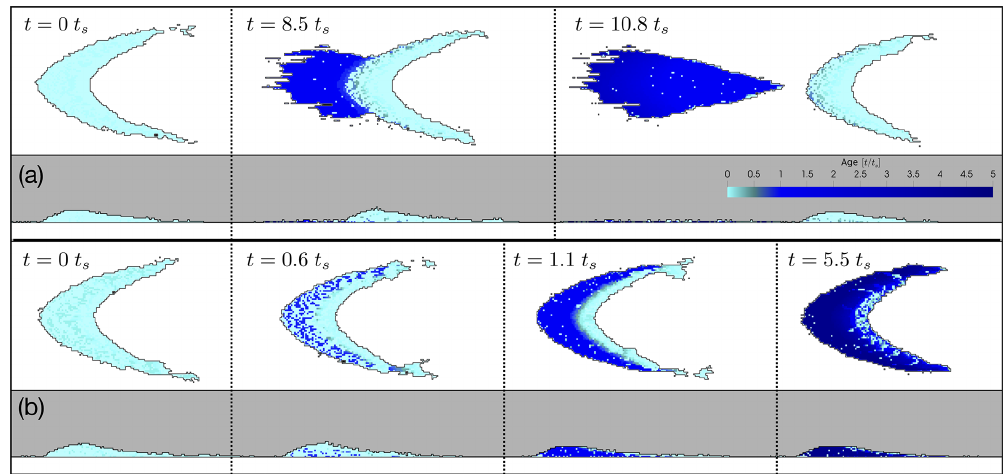
Figure 6. Effect of sintering on the morphodynamics of a mobile barchan (case C20): (a) medium-wind ( U 1m = 12 . 5ms − 1 ) and (b) low- wind ( U 1m = 7 . 0ms − 1 ) scenarios. Note that the colour scheme is such that light blue colours represent mobile (eDS-type) cells while darker shades of blue are sintered (neDS-type)